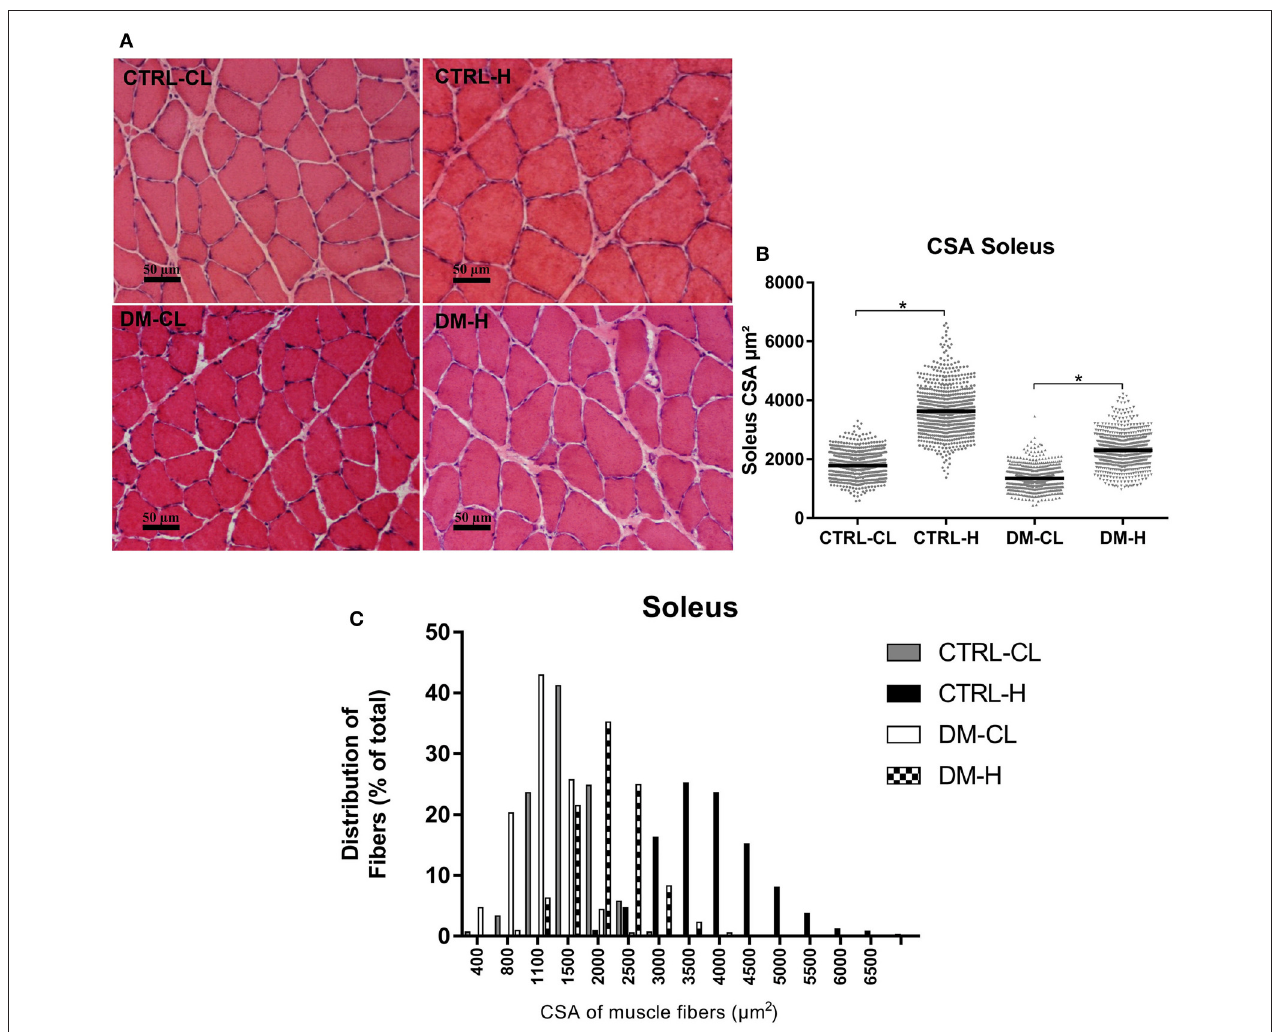
FIGURE 3 | Cross-sectional areas (CSA) of the soleus muscle fibers. (A) Representative histological hematoxylin and eosin staining images of the soleus muscle CSA. Reference bar represents 50 µ m. (B) Dispersion graph of soleus muscle fibers CSA. (C) Frequency distribution of the soleus muscle fibers according to the CSA ranges: 0–7,000 µ m 2 . The results were analyzed as previously described using the 95% confidence interval of the median. *Significant difference considering the 95% confidence interval of the median. CTRL-CL, control group, contralateral muscle; CTRL-H, control group, hypertrophied muscle; DM-CL, diabetic group, contralateral muscle; DM-H, diabetic group, hypertrophied